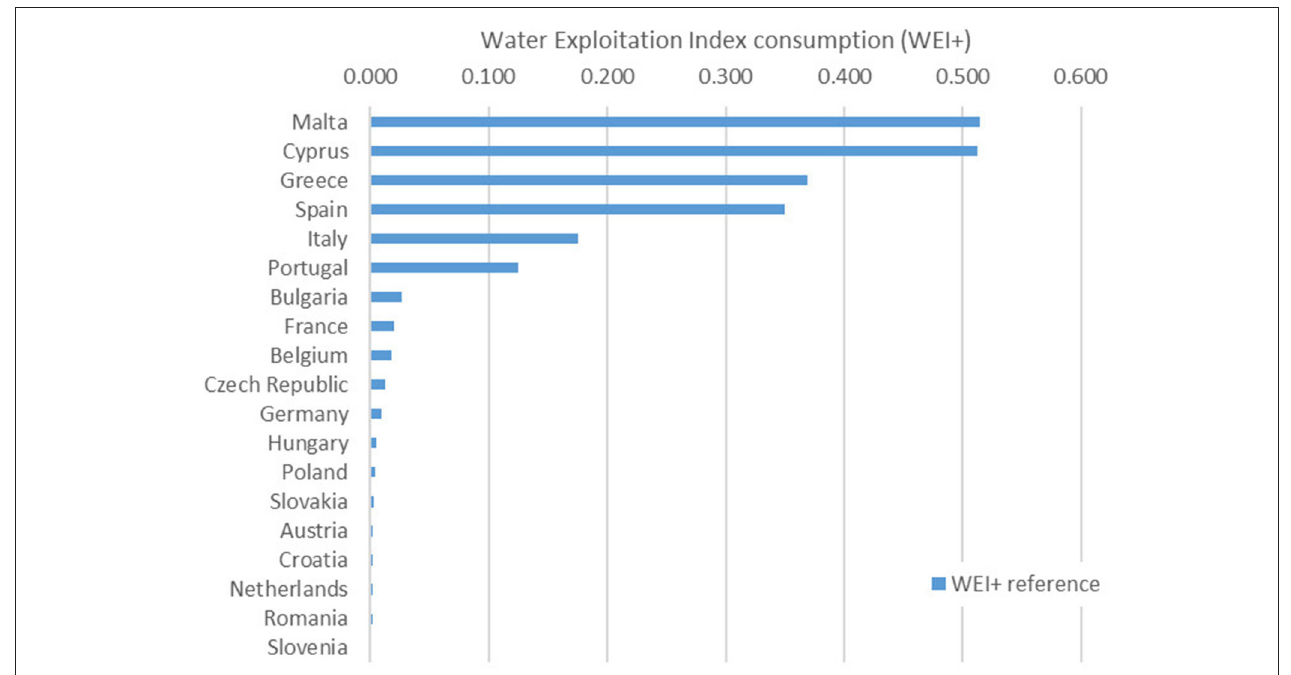
FIGURE 2 | The Water Exploitation Index (WEI + ), estimated using the LISFLOOD model, averaged for European countries for